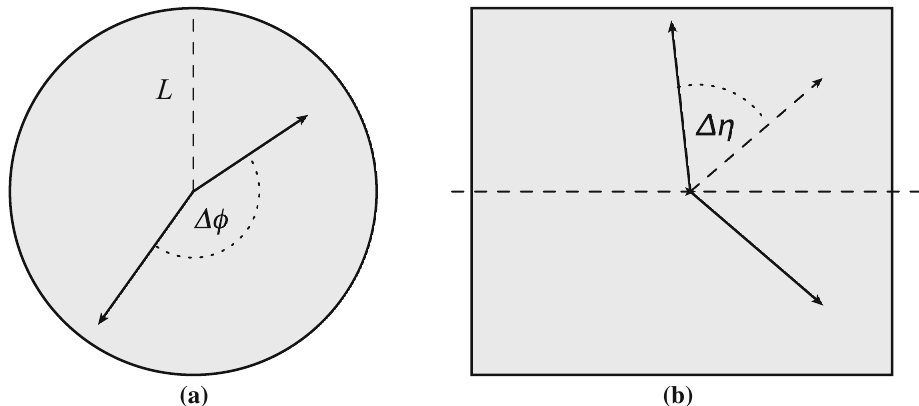
Fig. 1 Illustration of jets passing through the nuclear medium. The jets pass through the medium L . a Azimuthal cross section of the nuclear medium. b Longitudinal cross section of the nuclear medium